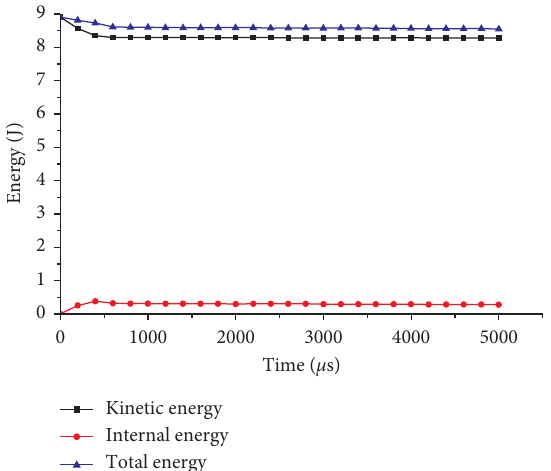
Figure 8: Energy-time history at a velocity of 4 m/s.